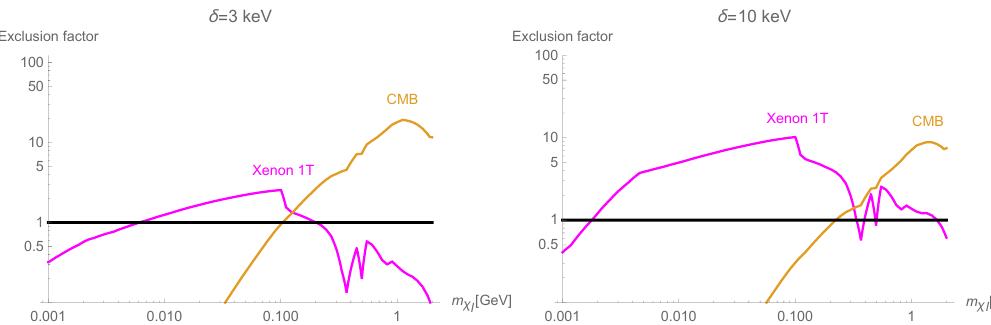
Figure 10 . Exclusion factors for regions near a mass splitting of order keV. The regions where the Xenon 1T and CMB lines are above 1 are excluded. The exclusion factor for Xenon 1T is given by the expected counts, eq. (7.7), over the maximum counts that could have occurred in the detector, while the CMB one is given by the inverse of eq. (5.6). Note that the exclusion factor is smaller than 10 for a large range of DM